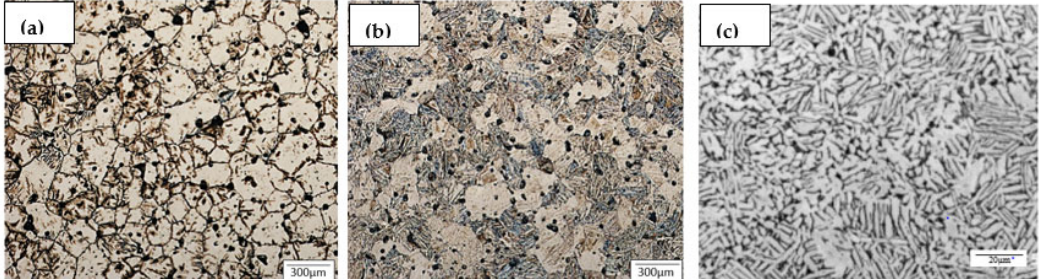
Table 1. The purity level of different powders by using XRF analysis.